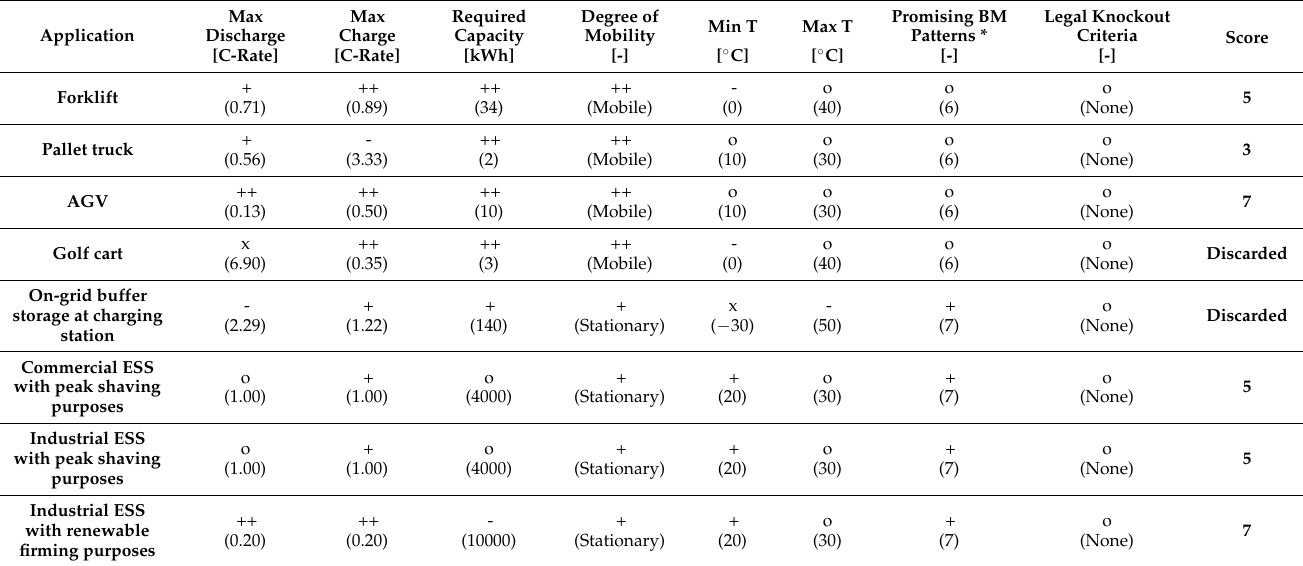
Table 2. Filled evaluation matrix with real values linked to the applications under